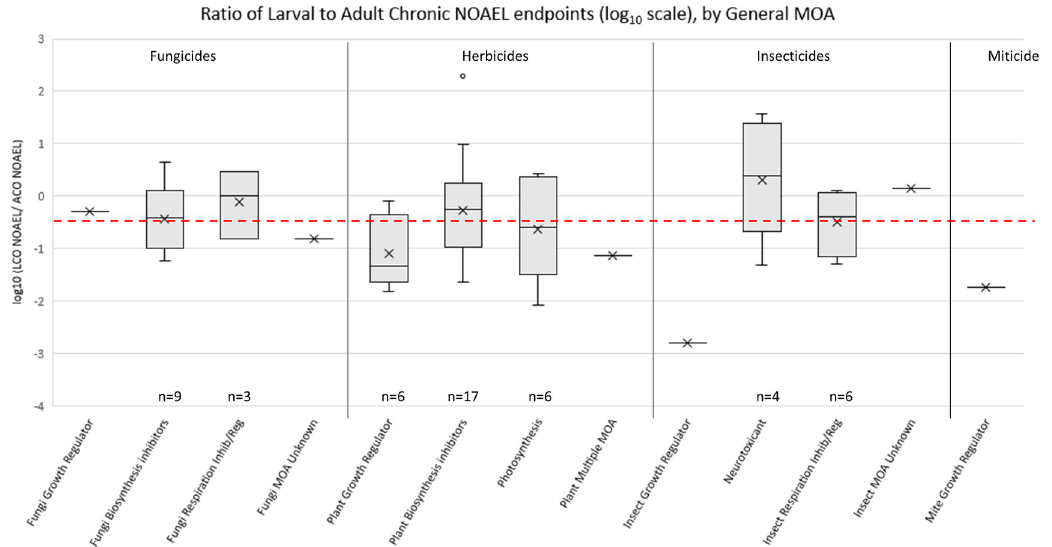
Fig 5. Ratio of honey bee ( Apis mellifera ) chronic mortality-based NOAEL endpoints from larval (LCO; OECD GD 239) and adult (ACO; OECD 245) toxicity studies. NOAEL ratios are organized by general mode of action (MOA), within pesticide type. Red dashed line represents the ratio of equivalence for dietary dose comparisons of larvae to adult bees. [sample sizes n > 1 are provided below boxes, n of 1 is indicated with an “-x-“; shaded boxes represent first quartile to the third quartile, “x” represents the mean, horizontal bar is the median, whiskers extend out to the 95 th